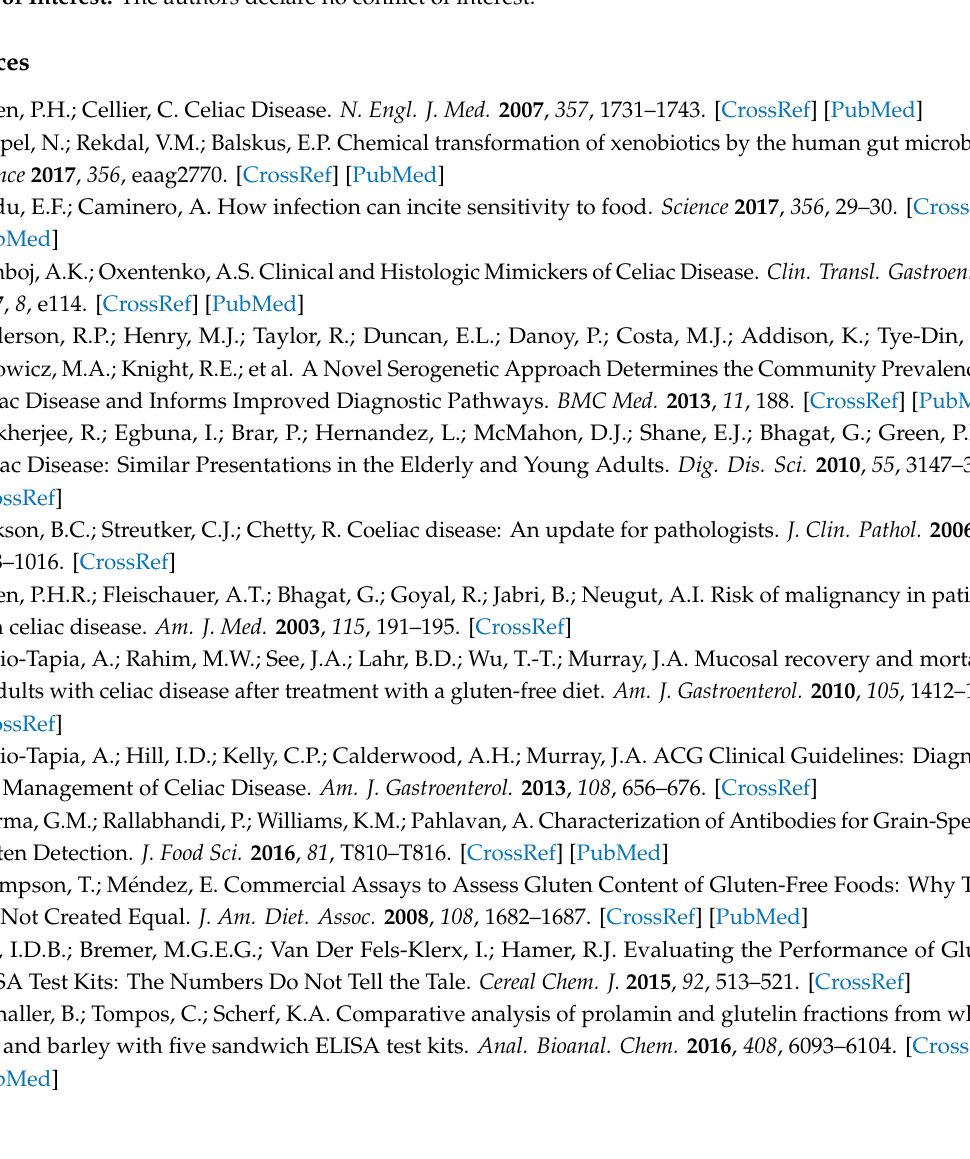
Table S1: Protein identifications in breakfast cereals (BC), Table S2: Protein identifications in breakfast bars (BB), Table S3: Protein identifications in milk-based breakfast drinks (BM), Table S4: Protein identifications in powdered drinks (PD), Table S5: Protein identifications in the savory spread (SS), Table S6: Ingredients and gluten peptide number identified in each food product type, Table S7: Gluten peptides detected in breakfast cereals (BC), Table S8: Gluten peptides detected in breakfast bars (BB), Table S9: Gluten peptides detected in milk-based breakfast drinks (BM), Table S10: Gluten peptides detected in powdered drinks (PD), Table S11: Gluten peptides detected in savory spread (SS), Table S12: MRM transitions for the wheat, rye, barley, and oat peptide markers assessed in food